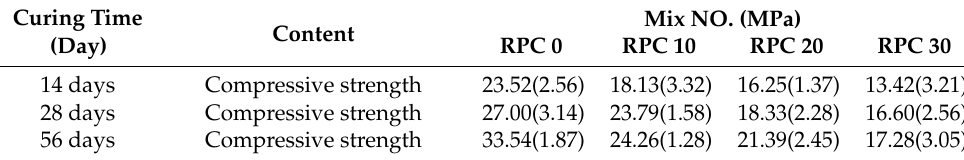
Table 3. Compressive strength of